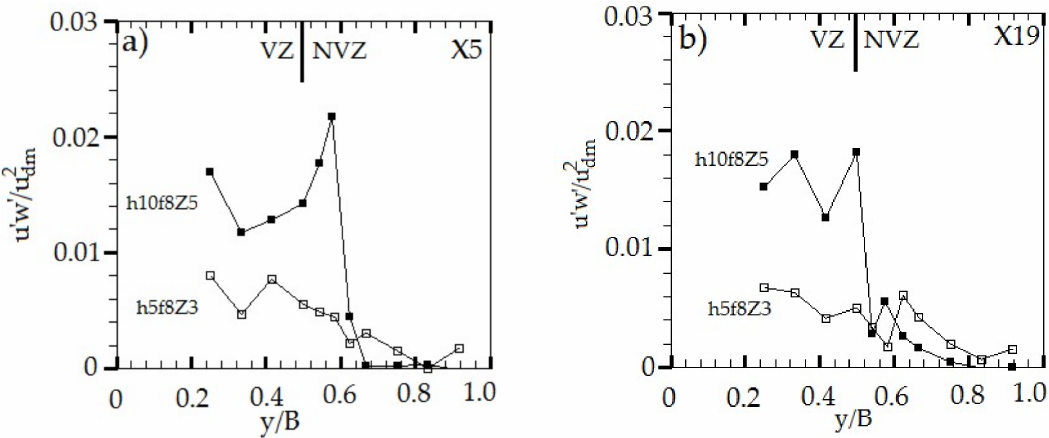
Figure 17. Non-dimensional Reynolds stresses distribution at the top edge of the vegetation layer along the spanwise direction; ( a ) X5; ( b )